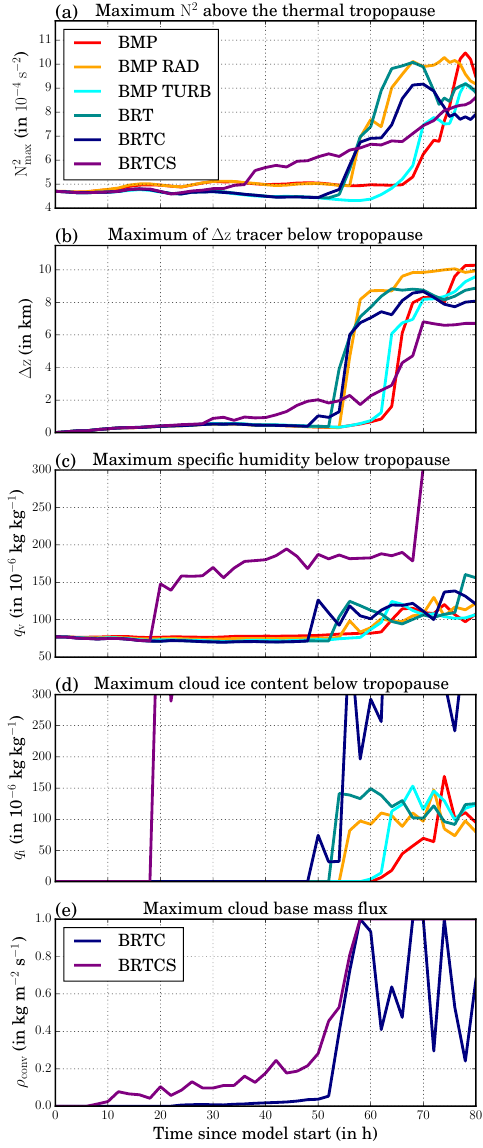
Figure 10. Temporal evolution over the first 80h of the life cycles of (a) N 2 max (in 10 − 4 s − 2 ) above the thermal tropopause, (b) the max- imum of the (cid:49)z tracer (in km) in a 500m thick layer below the ther- mal tropopause, (c) the maximum specific humidity q v in a 500m thick layer below the thermal tropopause (in 10 − 6 kgkg − 1 ), (d) the maximum specific cloud-ice content q i in a 500m thick layer below the thermal tropopause (in 10 − 6 kgkg − 1 ), and (e) the maximum cloud base mass-flux ρ CONV (in kgm − 2 s − 1 ). The time of TIL oc- currence is split into three time sectors. Without radiation and con- vection, the TIL appears after 65h, with radiation between 50 and 65h, and with strong convection before 50h (more information is given in the text). The colored lines indicate the following simula- tions: BMP (red), BMP RAD (orange), BMP TURB (cyan), BRT (dark cyan), BRTC (dark blue), and BRTCS